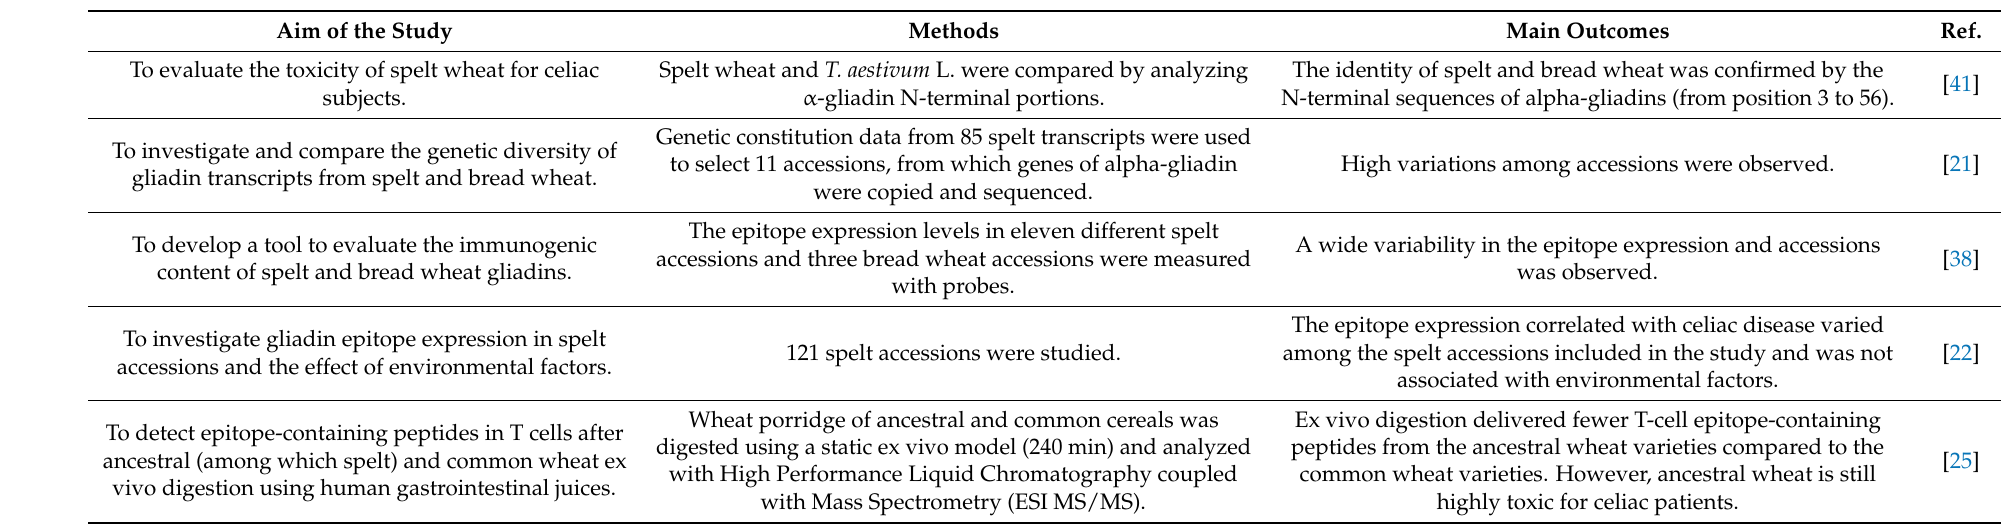
Table 6. Toxicity of spelt ( T. aestivum ssp. spelta ) based on proteomic